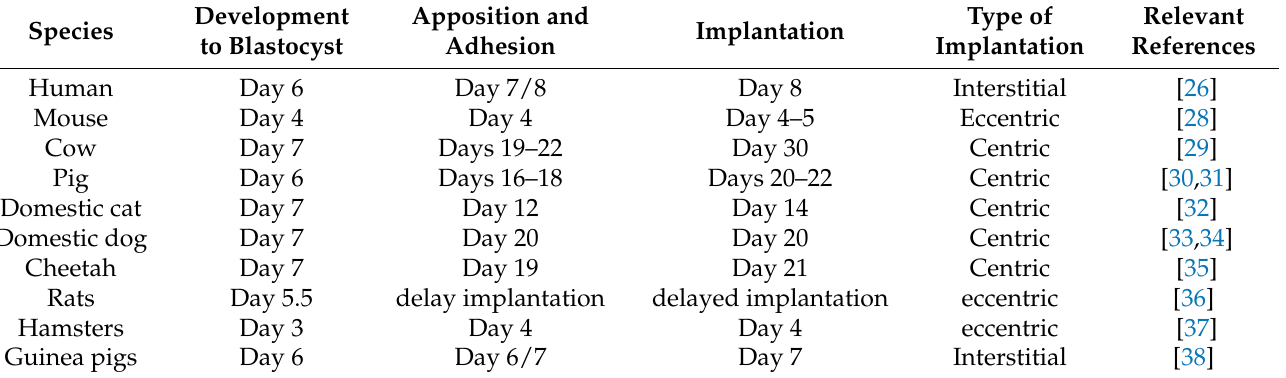
Table 1. The timing of the implantation, which corresponds to the beginning of placental development and the length of gestation between